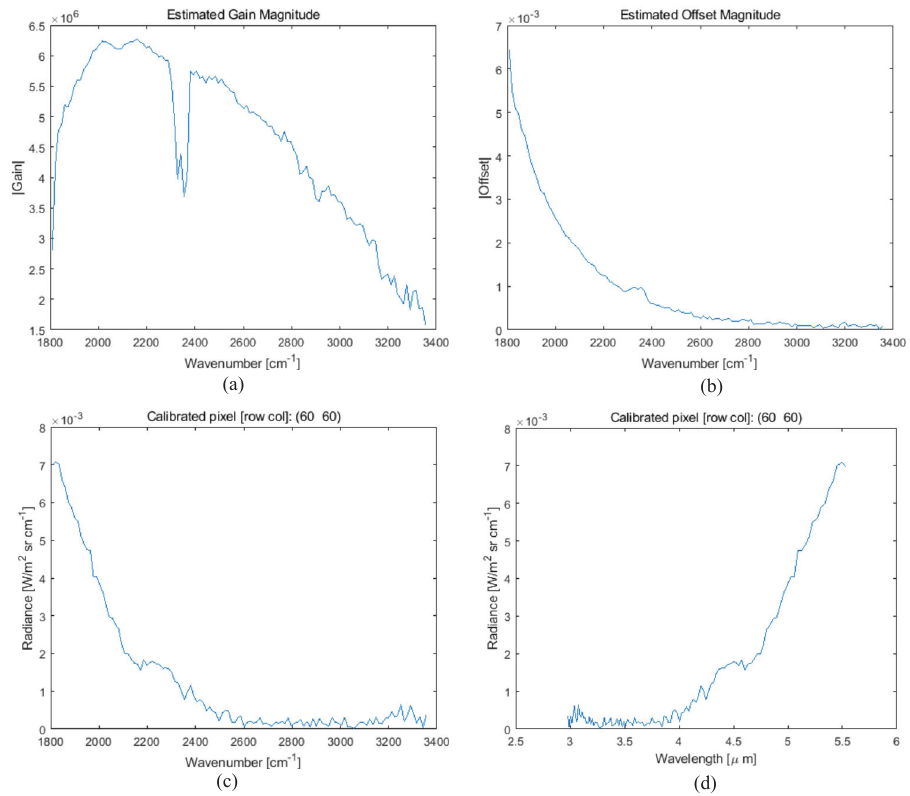
Figure 5. Radiometric calibration and spectral radiance extraction: ( a ) estimated gain magnitude; ( b ) estimated offset magnitude; ( c ) spectral radiance vs. wavenumber; ( d ) spectral radiance vs. wavelength.